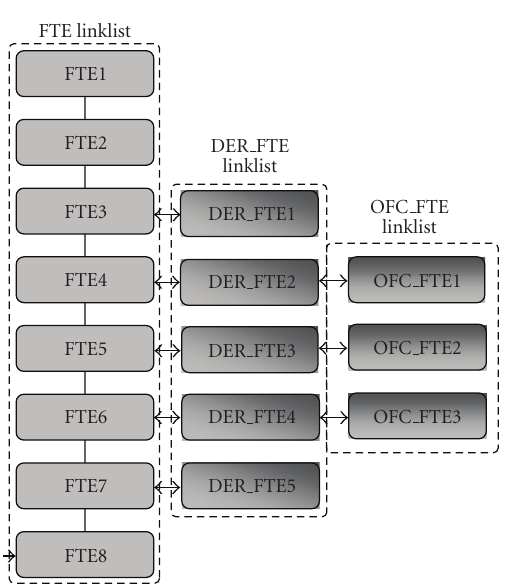
Figure 3: OFC module diagram.